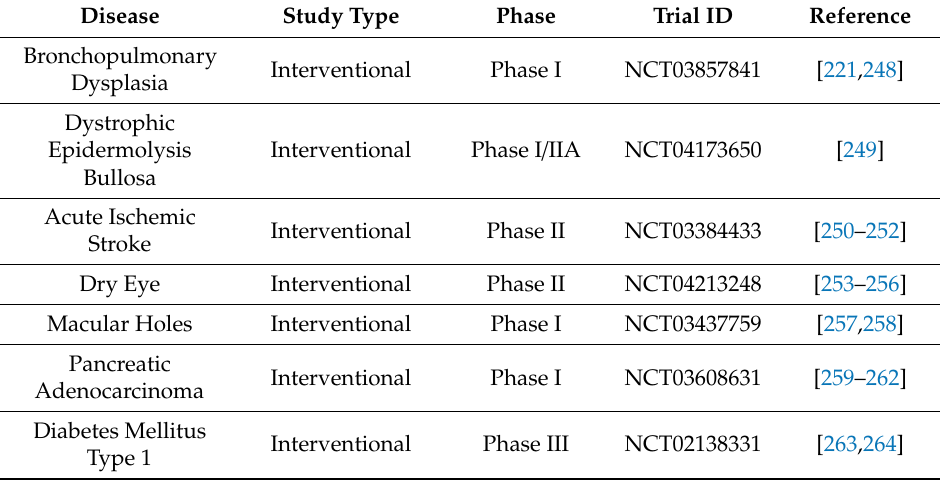
Table 4. Summary of the clinical trials involving MSC-extracellular vesicles